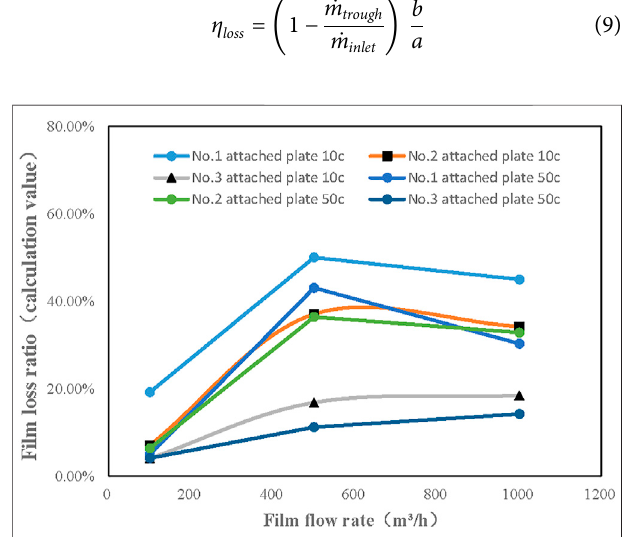
FIGURE 9 | In fl uence of fi lm fl ow rate on the fi lm loss